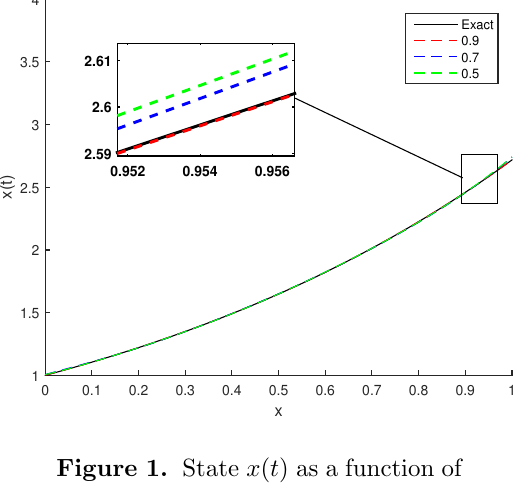
Figure 1. State x ( t ) as a function of t for the Example 1 for m = 7 and different values of α (green: α = 0 . 5, blue: α = 0 . 7, red: α = 0 . 9.